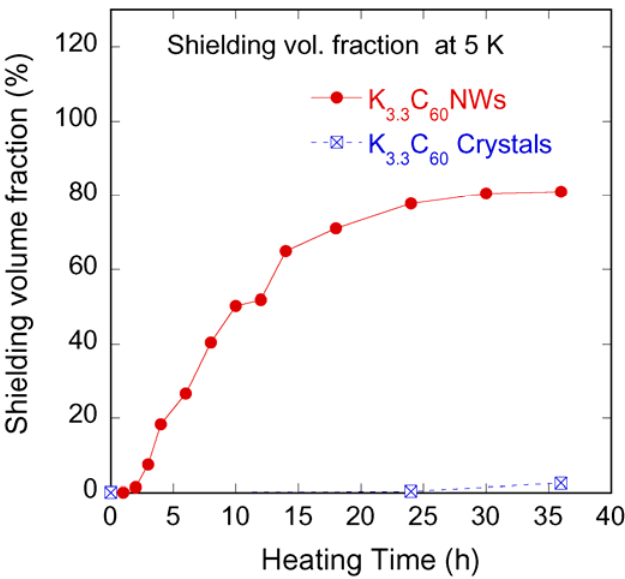
Figure 4. Formation of superconducting phase (%) in K volume fractions vs. heating time (h) at 200 °C.